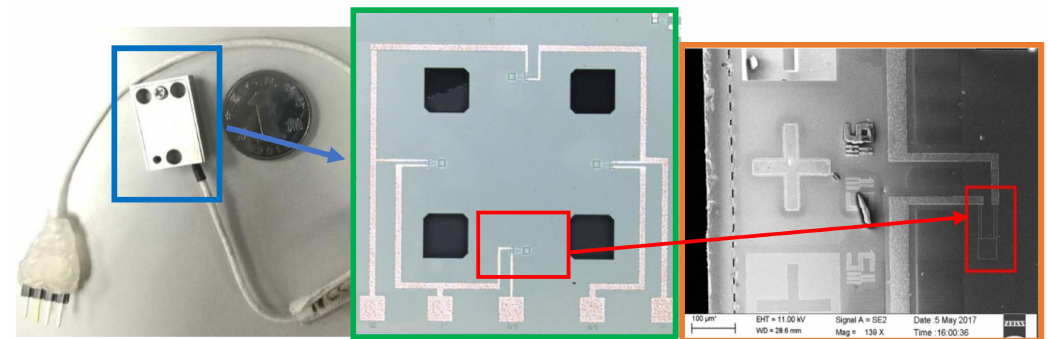
Figure 7. Overall photo, charge coupled device (CCD) photo and SEM photo of the